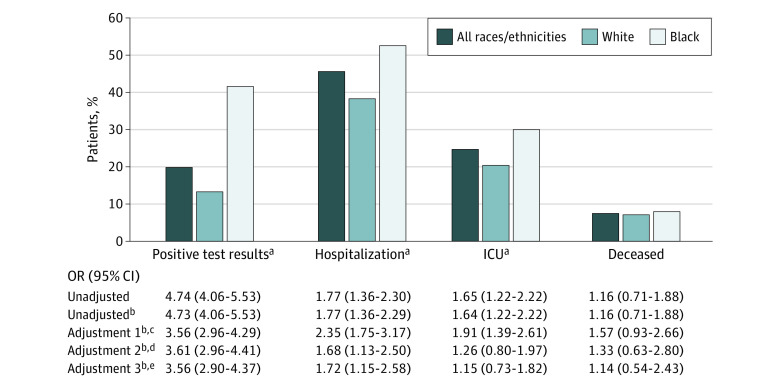
Coronavirus Disease 2019 Outcomes by Race/EthnicityAbbreviations: ICU, intensive care unit; OR, odds ratio.aχ2 test P < .001, comparing the proportion between White and Black patients.bLogistic regression with Firth correction.cMultivariable logistic regression with adjustment 1 (ie, age, sex, race/ethnicity; having test results positive for coronavirus disease 2019 also adjusted for population density).dMultivariable logistic regression with adjustment 2 (adjustment 1 + Neighborhood Disadvantage Index).eMultivariable logistic regression with adjustment 3 (adjustment 2 + comorbidity score).